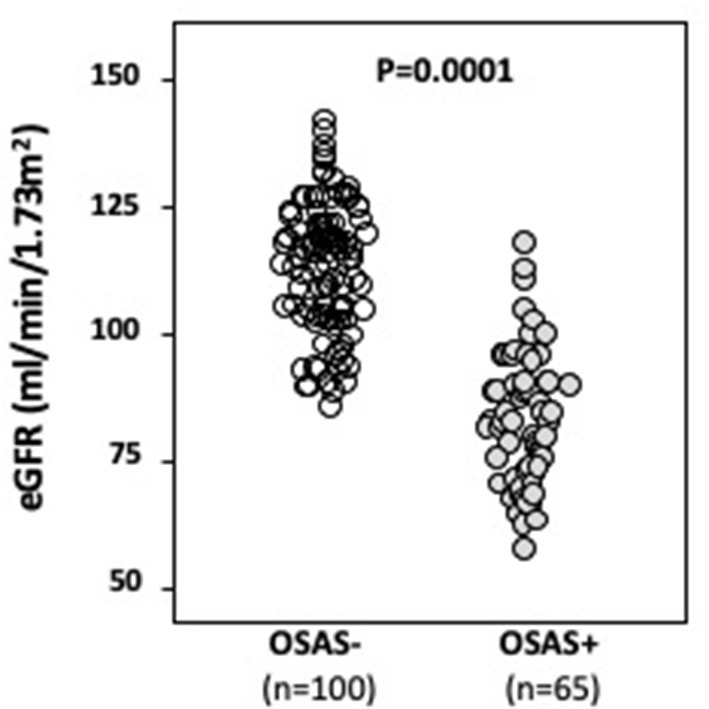
Mean e-GFR baseline values in OSAS– and OSAS+ groups. In this figure, we graphically reported mean baseline e-GFR values of both OSAS– and OSAS+ groups. As indicated, OSAS+ subjects showed statistically significant lower baseline e-GFR values when compared to OSAS– subjects.